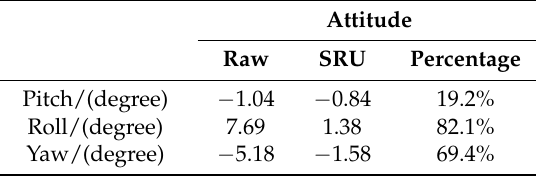
Table 7. Attitude results